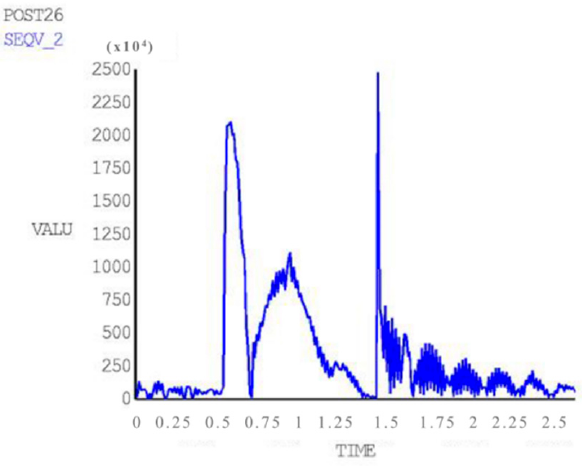
Figure 9. Stress response curve of RP 2.